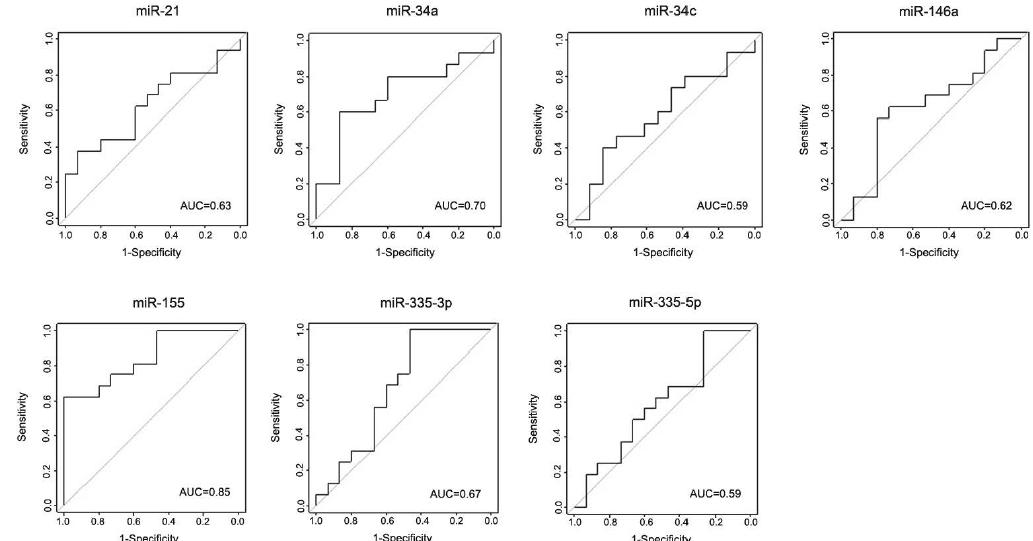
Figure 4. Receiver operating characteristic (ROC) curves of miRNAs in the validation cohort, discriminating between controls and iPD patients. The true positive rate (sensitivity %) is plotted as a function of the false positive rate (100%—specificity) for the seven miRNAs individually. Area under the curve (AUC) values are indicated in each plot.